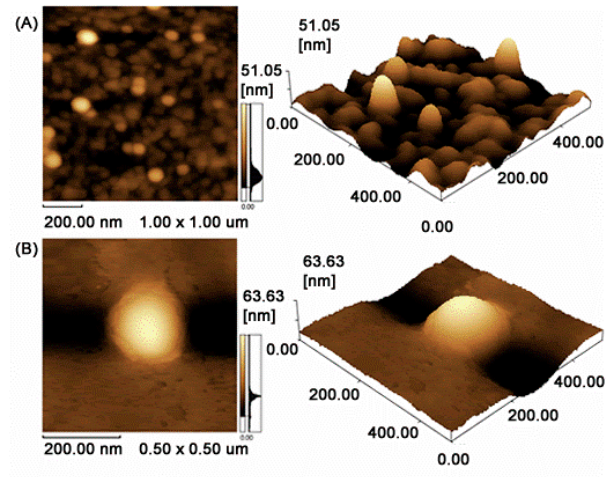
Figure 1. AFM images of ( A ) blank nanoparticles and ( B ) drug-loaded nanoparticles in 2D and 3D, respectively.